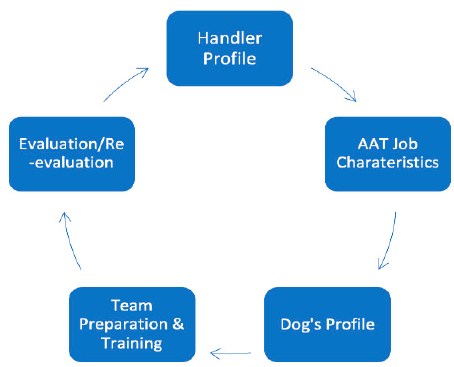
Figure 1. Framework for selection, preparation and evaluation of dogs working in AAT.